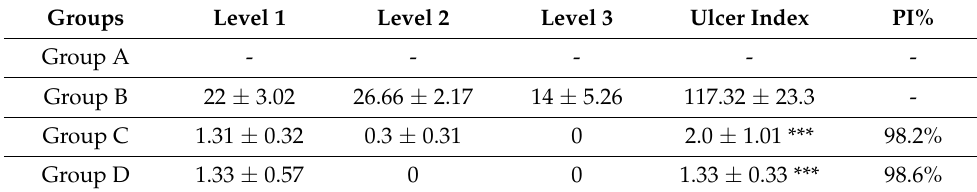
Table 1. Antiulcer activity of guava seed extract. Groups